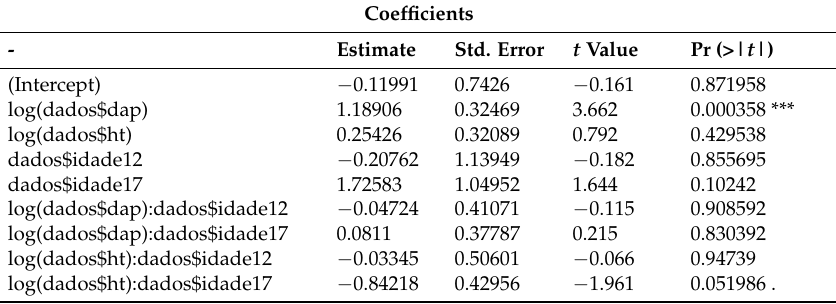
Table A17. R software output table with significance values resulting from ANCOVA for CFM using C 10 as reference for comparison of C 12 and C 17.